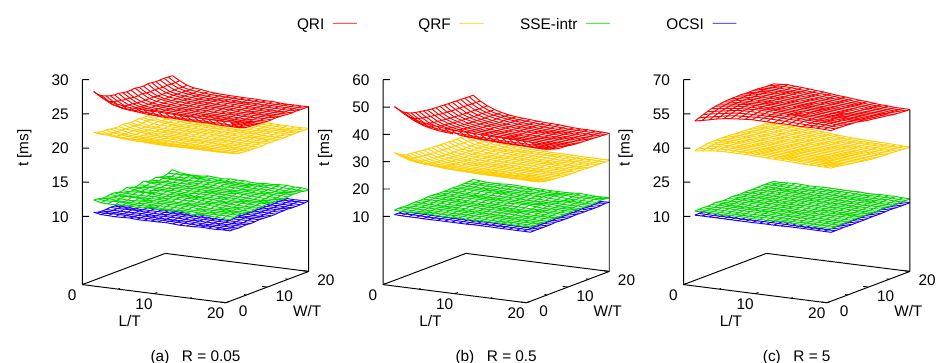
Figure 2. Run-times of algorithms written in C/C++ that detect collision between one cuboid of length L ∗ and width W ∗ and one sphere of radius R ∗ = 0.05 ( a ), 0.5 ( b ) and 5 ( c ). The program was compiled using Intel ® C Compiler and enabled the generation of Advanced Vector Extensions (AVX) instructions. Each test generates 2 10 6 random configurations at constant acceptance ratio of 40%. ×